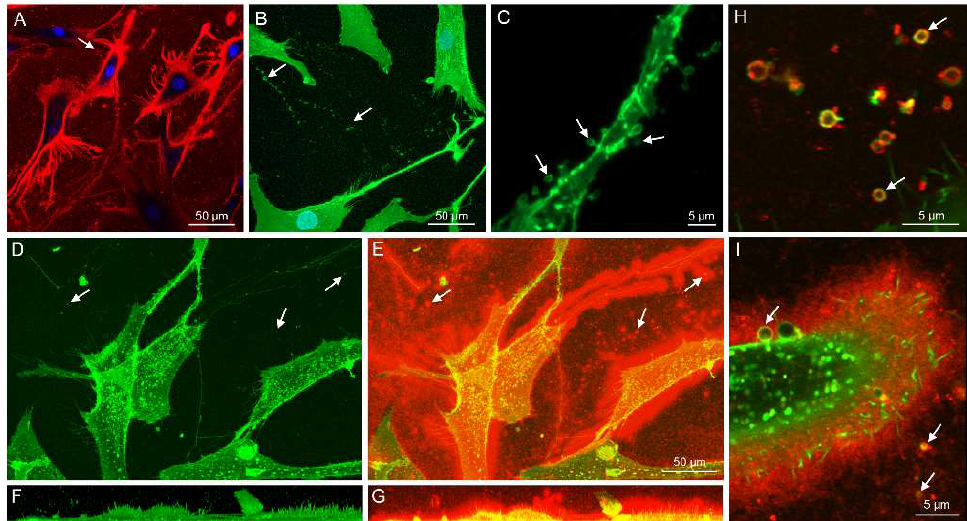
Figure 1. Confocal optical section of live fibroblast-like synoviocytes stained with Alexa Fluor 568-labeled hyaluronan (HA) binding complex (HABC) and NucBlue (pseudocolored red and blue, respectively, panel ( A )). Fixed and immunostained cells with CD44 antibody (pseudocolored green) as maximum intensity projection from a stack of images (panel ( B )) and the same culture imaged with super-resolution to indicate extracellular vesicle (EV) budding from the membrane of a single cell (panel ( C ) (maximum intensity projection from a stack of images). Live cells labeled with CellMask Deep Red plasma membrane stain (pseudocolored green, panel ( D ) and merged with Alexa Fluor-labeled HABC to detect HA (pseudocolored red, panel ( E ) as maximum intensity projections from a stack of images. The corresponding side views of panels ( D ) and ( E ) are shown in panels ( F ) and ( G ), respectively. Super-resolution (Airyscan ® ) optical sections from the same cultures shown in panels D–G indicate single EVs of variable size that are attached to the bottom of the culture plate (pseudocolored green, panel ( H )) and a more detailed structure of the HA coat around the plasma membrane with budding EVs (pseudocolored red, panel ( I )). Arrows in all panels indicate EVs. After EV collection from FLS-conditioned media, nanoparticle tracking analysis (NTA) and CLSM were utilized to observe the number and size distribution of EVs. The main population was <200 nm in diameter as determined by NTA (Figure 2). With CLSM,